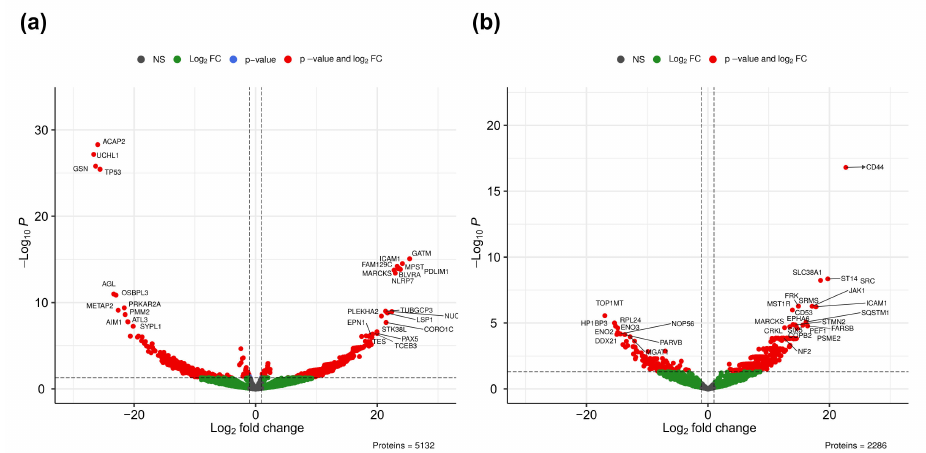
Figure 4. Volcano plots based on quantified proteins in whole proteome ( a ) and EVs ( b ). NS, nonsignificantly expressed proteins (grey); nonsignificantly differentially expressed proteins with at least two-fold regulation (green); and P & Log 2 FC, significantly expressed proteins